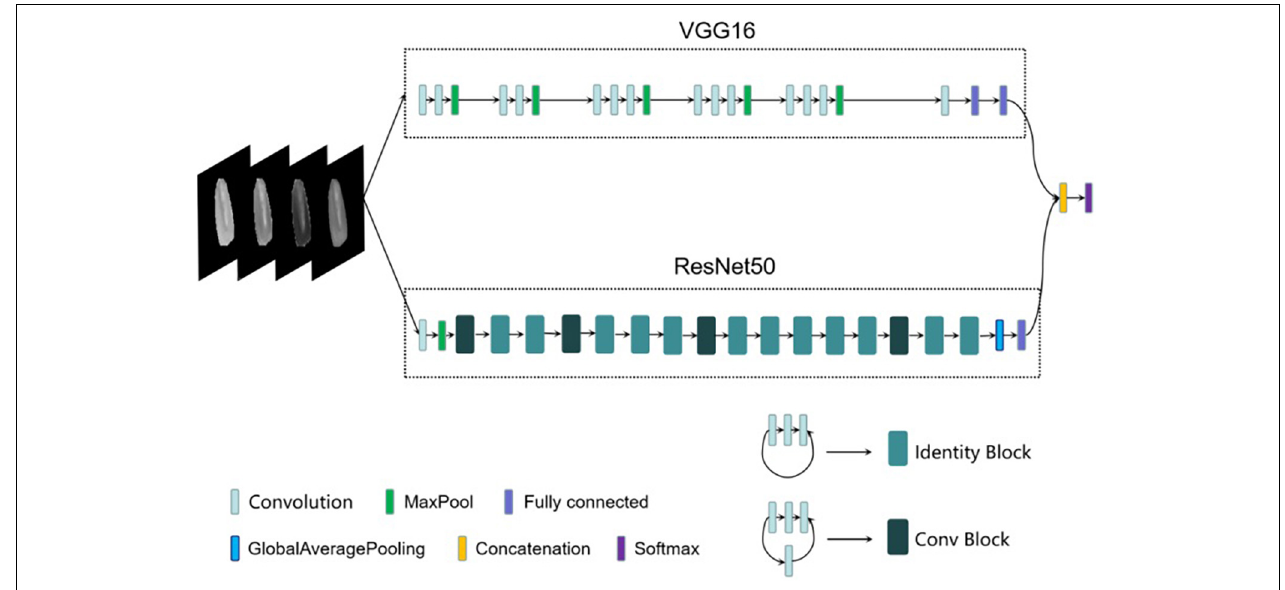
FIGURE 5 | Corn-seed-Net network architecture.